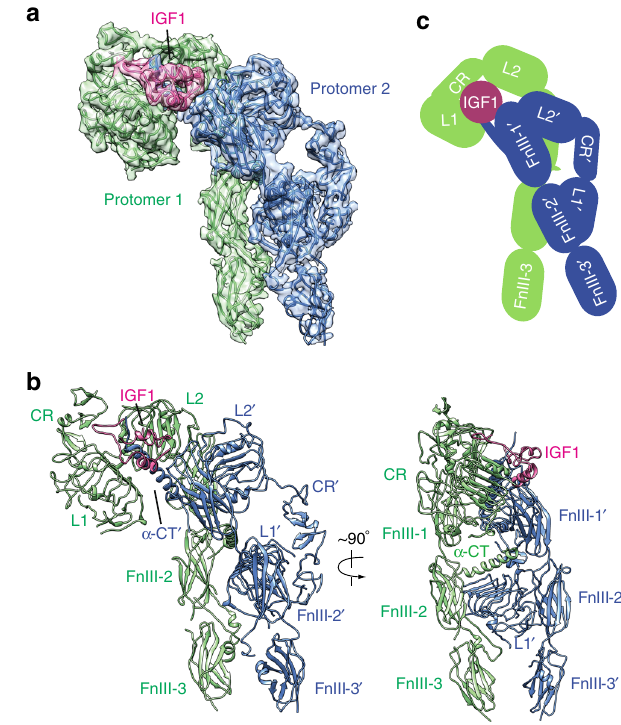
Fig. 1 Overall structure of the IGF1R-IGF1 complex. a 3D reconstruction of the IGF1R dimer with one IGF1 bound and the corresponding ribbon representation of this complex fi tted into cryo-EM map. b The ribbon representation of IGF1R-IGF1 complex showing in two orthogonal views. c Cartoon representation of the IGF1R-IGF1 complex depicting the IGF1R dimer bound with one IGF1. The two IGF1R protomers are colored in green and blue, respectively; the IGF1 is colored in pink. The name of each domain is labeled as follows: L1 and L2 (leucine-rich repeat domains); CR (cysteine- rich domain); FnIII-1, FnIII-2 and FnIII-3 ( fi bronectin type III domains); α -CT (the C-terminus of the α -subunit)